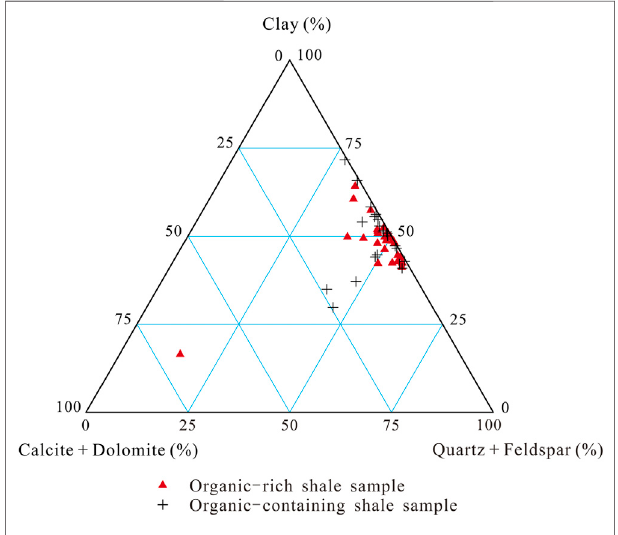
FIGURE 2 | Ternary diagram of mineral components for shale samples from the Shahezi Formation based on XRD.